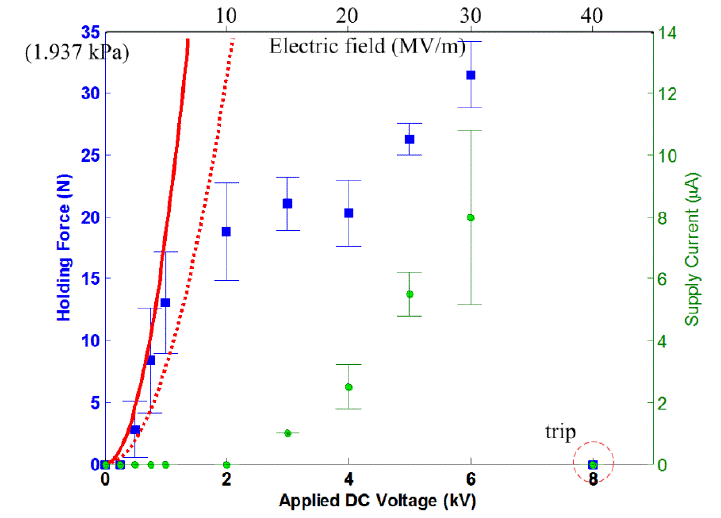
= 3.9, A = 18.06 × 10 −3 m 2 , d = 200 µm. r = s